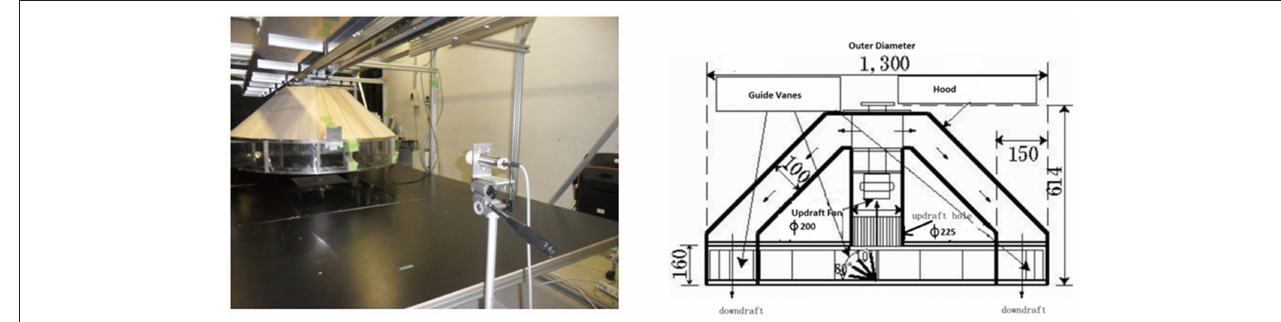
FIGURE 2 | Translating tornado-like flow simulator at Tokyo Polytechnic University and schematic showing the dimensions.